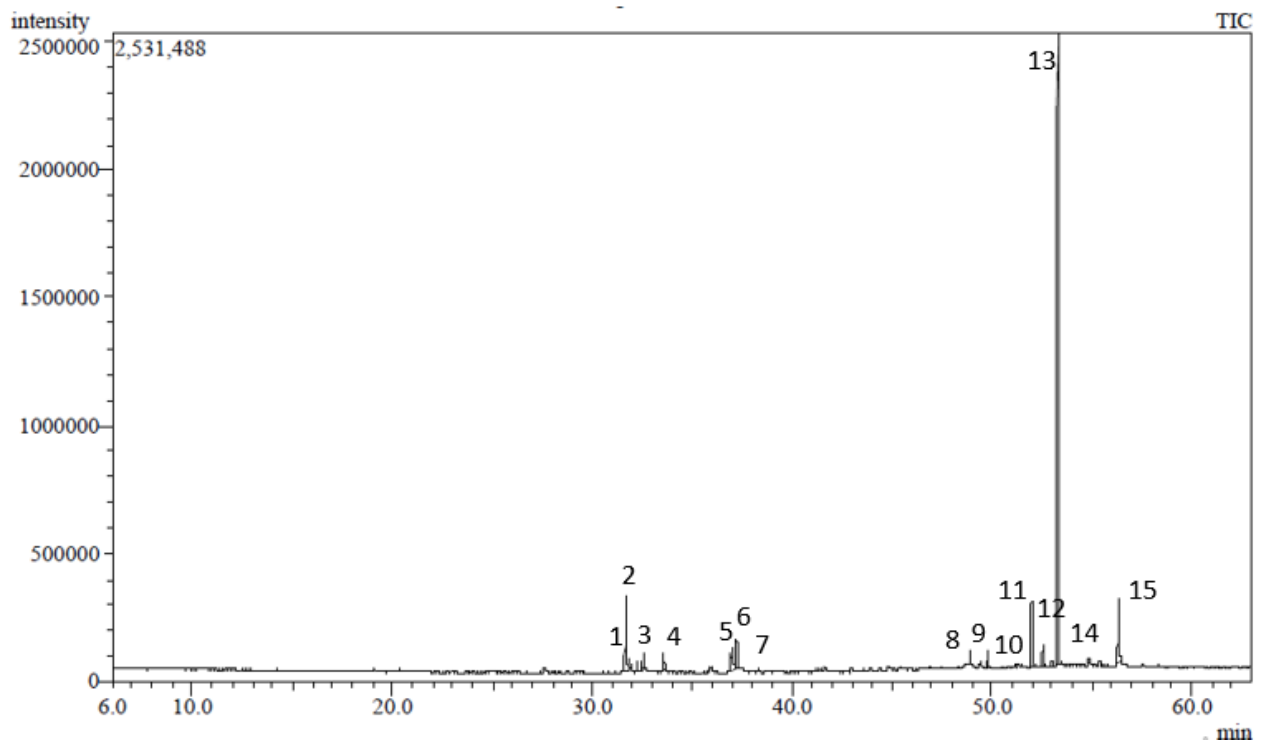
Figure 1. GC/MS chromatogram of Stenocarpus sinuatus hexane-soluble fraction.